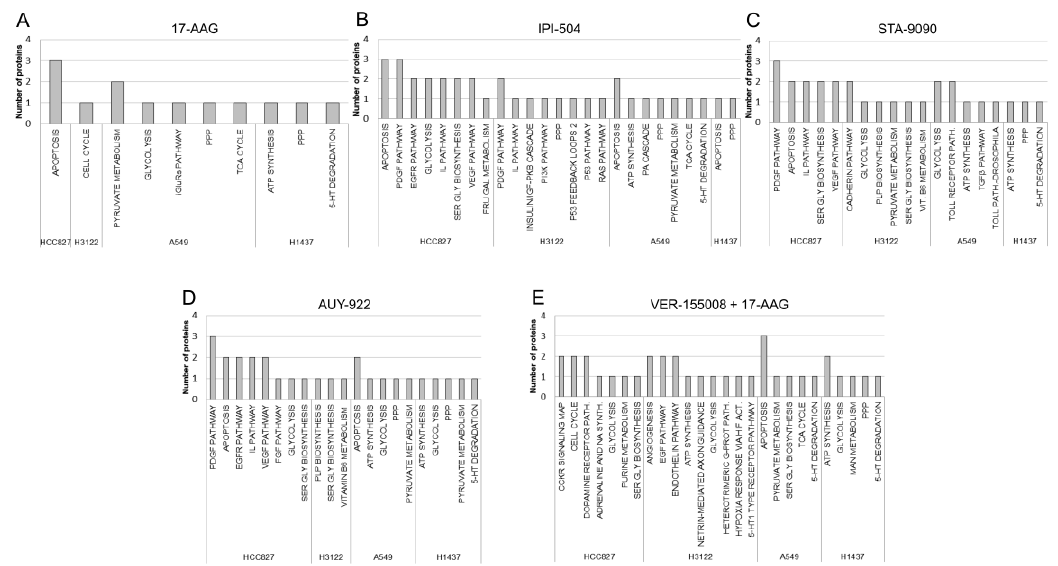
Figure 3. Canonical pathway analysis of proteins identified by two-dimensional electrophoresis and mass spectrometry (2-DE/MS) in response to HSP90 inhibition. Functional analysis of the differentially expressed proteins in response to ( A ) 17-AAG, ( B ) IPI-504, ( C ) STA-9090, ( D ) AUY-922 and ( E ) VER-155008 + 17-AAG inhibitors in the adenocarcinoma cell lines HCC827, H3122, A549 and H1437. Enriched pathways were determined from the PANTHER database. The number of proteins involved in each identified pathway is represented on the y axis. iGluRs pathway = ionotropic glutamate receptor pathway, PPP= pentose phosphate pathway, TCA cycle = tricarboxylic acid cycle, 5-HT degradation = 5-hydroxytryptamine or serotonin degradation, PDGF pathway = platelet-derived growth factor signaling pathway, EGFR pathway = epidermal growth factor receptor pathway, IL pathway = interleukin signaling pathway, SER GLY biosynthesis = serine and